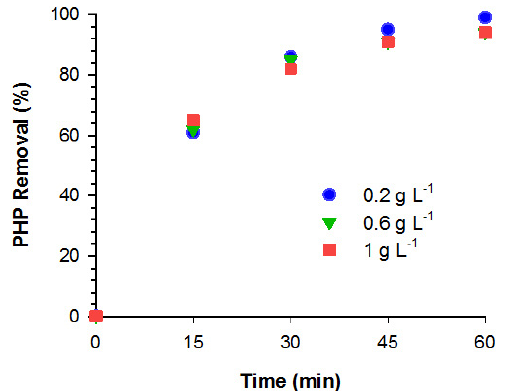
Fig. 8. Effect of the nanocatalyst concentration on the PHP re- Fig. 9. Effect of the applied current on the PHP removal efficien- moval efficiency. Reaction conditions: 0.1 A, pH=7, and [PHP] cy. Reaction conditions: pH = 7, [catalyst] = 0.2 g L -1 , and [PHP] =10 ppm. =10